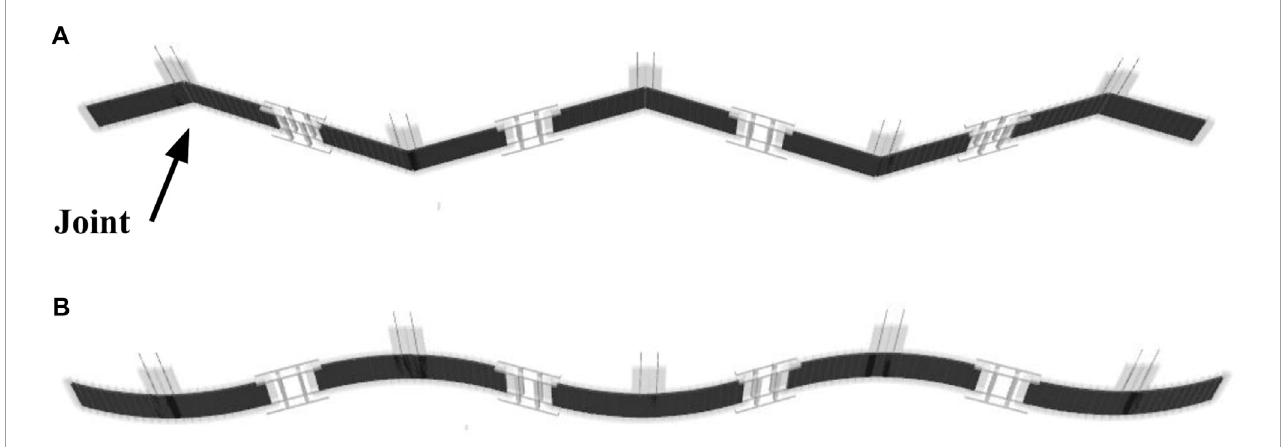
FIGURE 2 The simulation model of snake robots in MuJoCo. (A) The rigid snake robot. (B) The soft snake robot. One DoF per segment for both models.